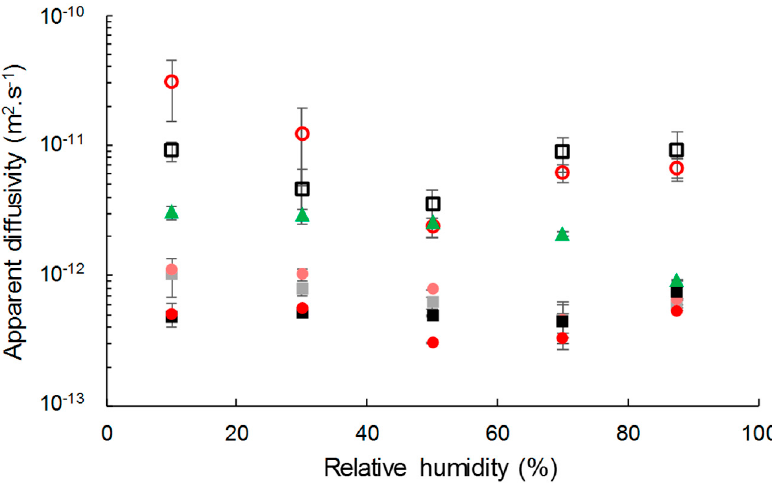
Figure 6. Apparent diffusivity of C-virgin ( □ ), C-grafted ( o ), PHBV ( ▲ ), PHBV-20VC ( ■ ), PHBV-20GC ( ● ), PHBV-33VC ( ■ ) and PHBV-33GC ( ● ).